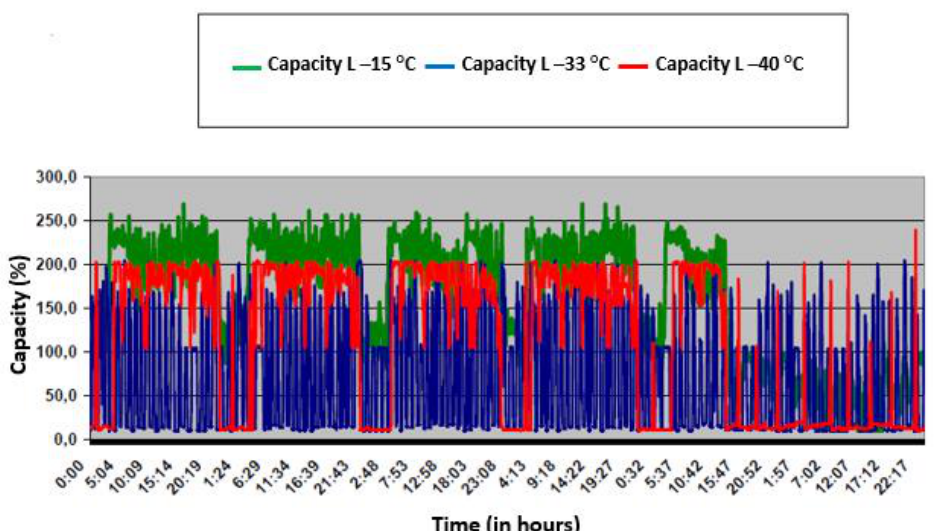
Figure 6. Operation profile of the different groups of compressors in the summer period.